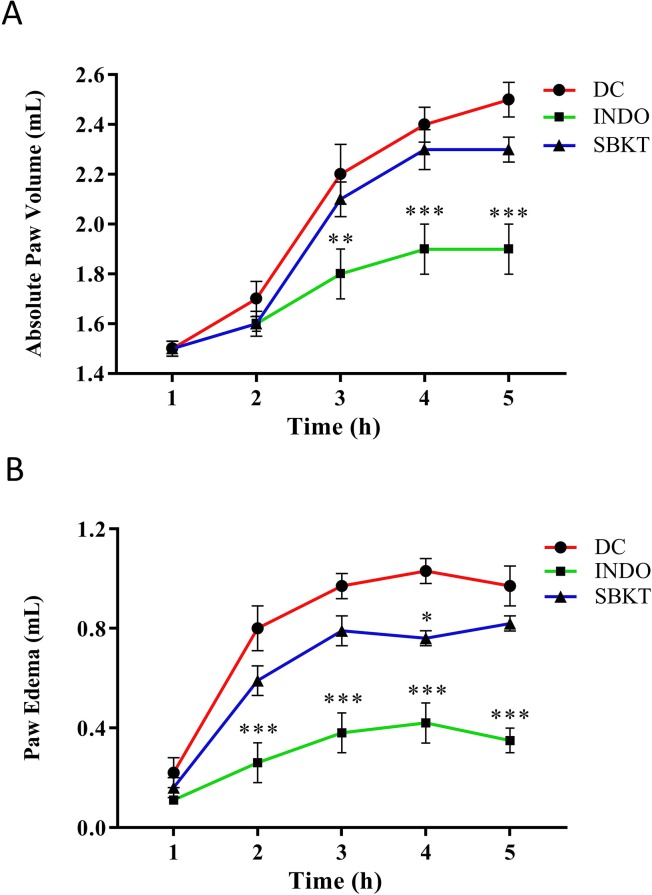
Effect of SBKT on λ-Carrageenan-induced paw rat edema model. Co-treatment of carrageenan-stimulated Wistar rats with SBKT [100 mg/kg; p.o. and 40 μl topical application (T.A.)] or with INDO (10 mg/kg; p.o.) led to a considerable reduction in their (A) absolute paw volume and (B) paw edema. Statistical analysis of the treatments was performed using two-way ANOVA followed by Newman–Keuls multiple comparison test (n = 7 animals). *p < 0.05, **p < 0.01, ***p < 0.001 (DC versus SBKT; DC versus INDO-treated animals). DC, disease control, SBKT, sea buckthorn oil; INDO, indomethacin.